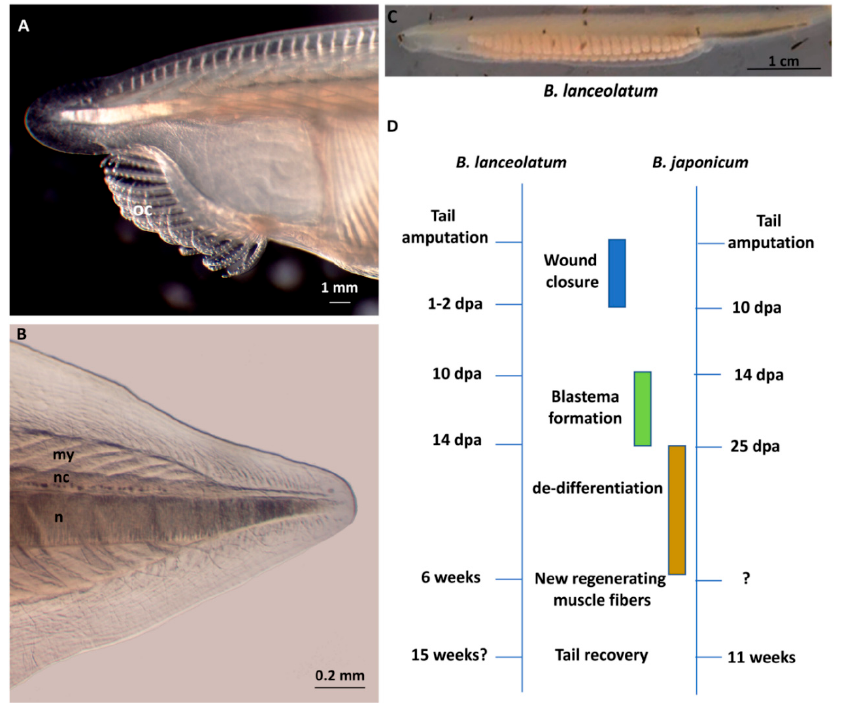
Figure 3. Timing and principal steps of regeneration in B. lanceolatum and B. japonicum . ( A ) Enlargement of the most anterior end of a Branchiostoma lanceolatum adult showing the oral cirri (oc). ( B ) Post-anal tail of the same animal. my, myomeres; nc, nerve cord; n, notochord. ( C ) B. lanceolatum individual collected in Banyuls-sur-Mer, France. ( D ) Schematic overview of the series of events occurring during tail regeneration in the B. lanceolatum and B. japonicum . dpa, days